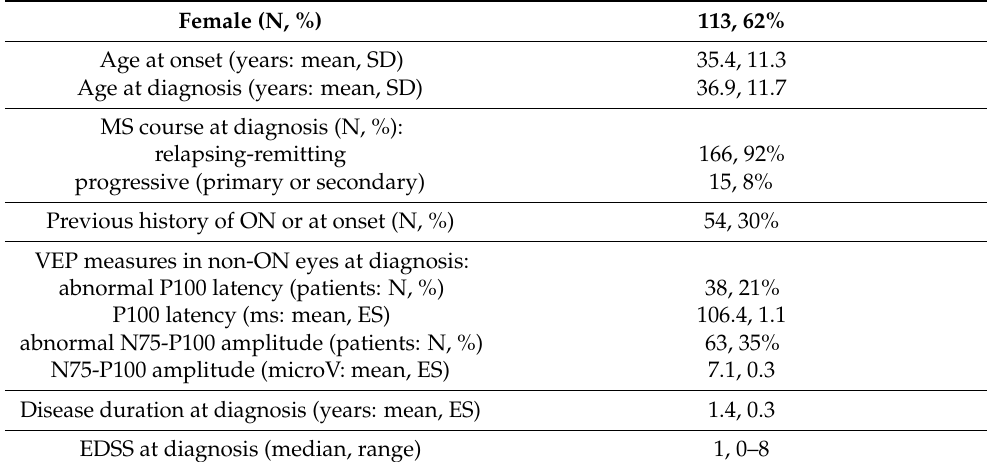
Table 1. Clinical–demographic features of patients collected at the diagnostic work-up (N = 181).